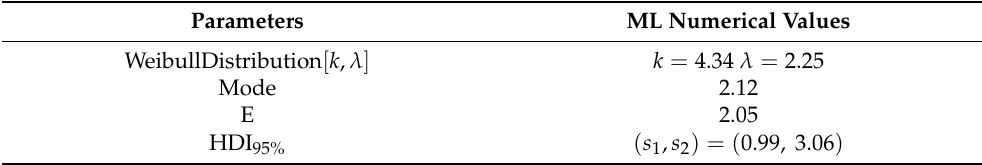
Table 1. Parameters of the ML distribution of the pain–pleasure distances of the 20 actresses; it is a Weibull distribution. E is the expectation and HDI 95% is the 95% highest density interval